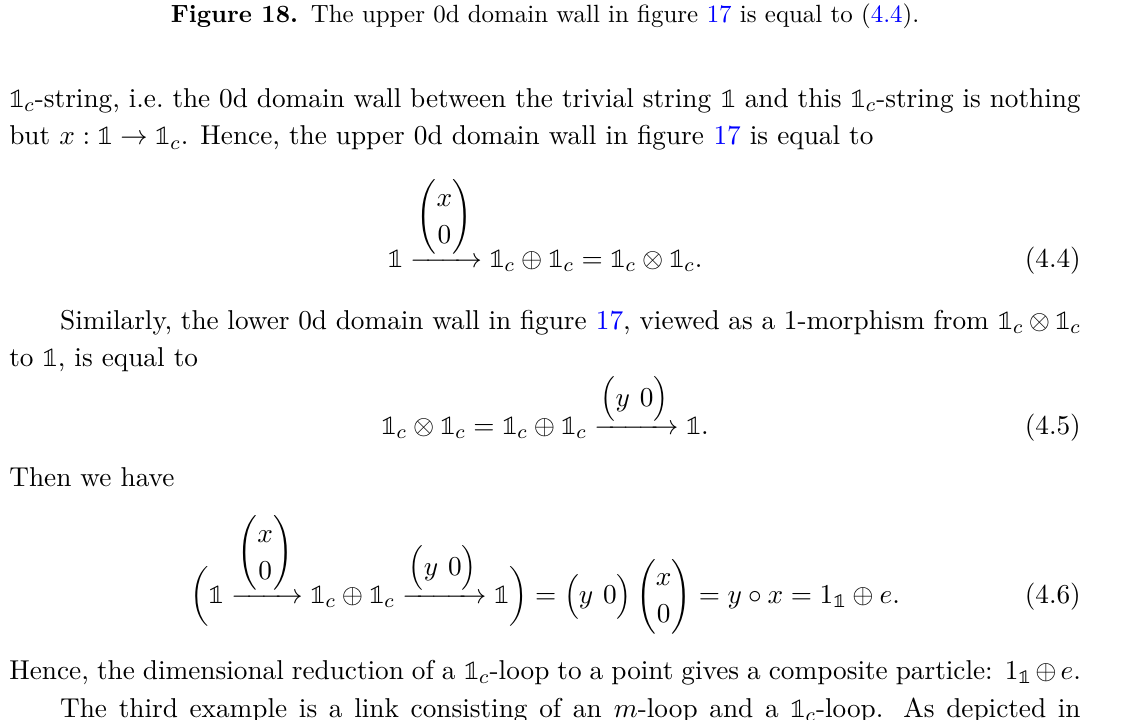
Figure 18. The upper 0d domain wall in figure 17 is equal to